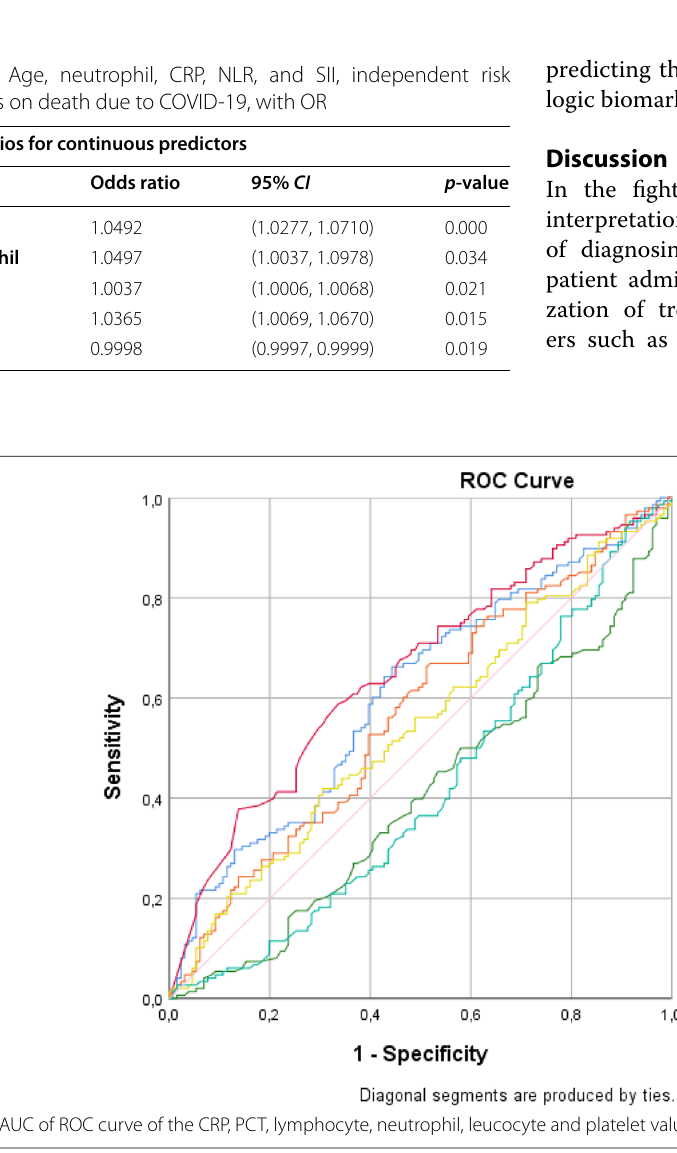
NLR (per μl)]. Mann-Whitney test was used ×